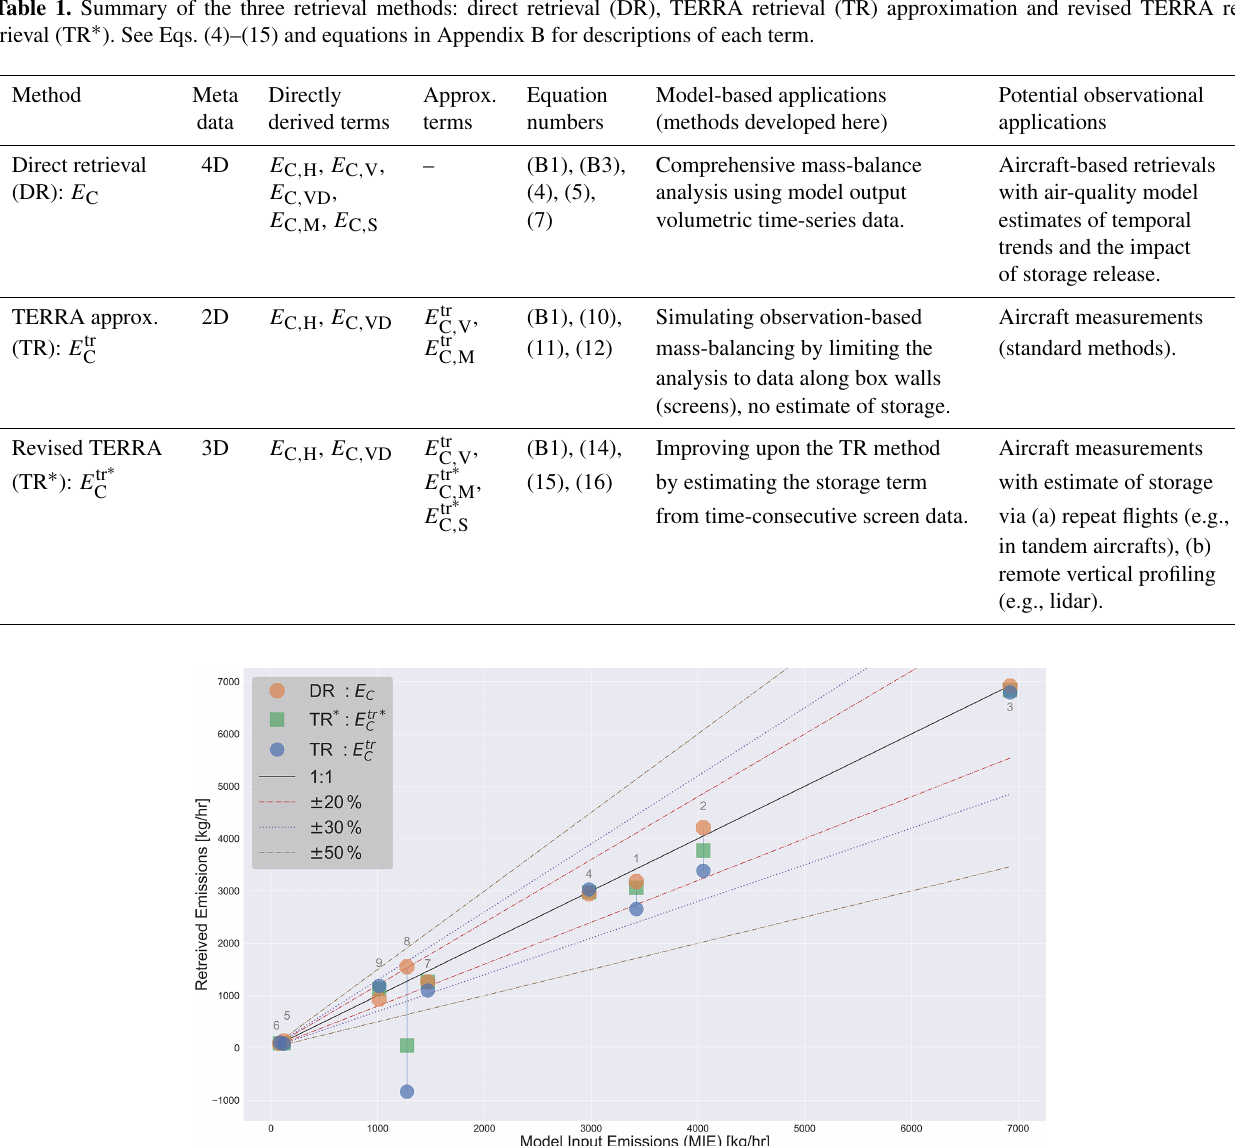
Figure 3. Emission rates determined by the three methods (DR, TR and TR ∗ ) are plotted against model input emissions (MIEs). The dark solid curve is the 1 : 1 MIE line; estimates below and above this line represent under- and over-estimation by the three methods. Case IDs are noted for each set. The vertical lines represent the error associated with storage-release events ( E C , S ) in TR estimates relative to MIEs. Also shown in the figure are the ± 50%, 30% and 20% error limits (dashed lines) for